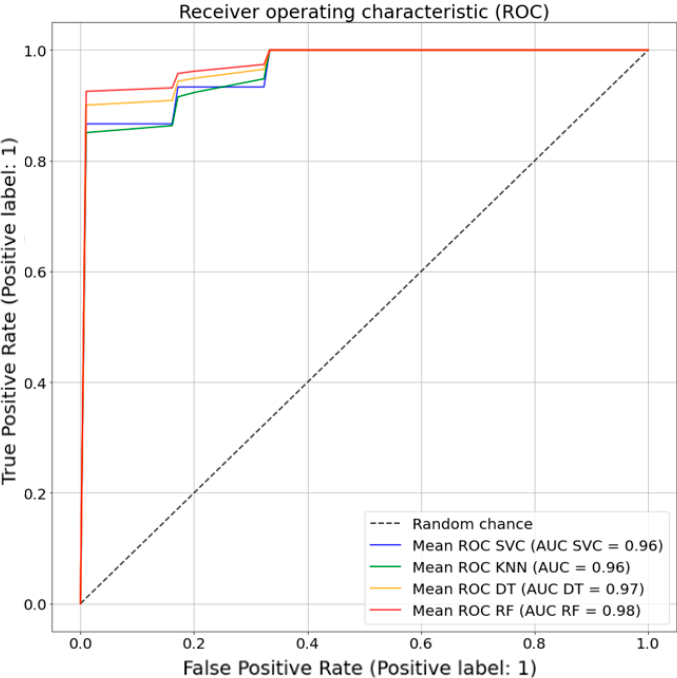
Figure 19. ROC curves and AUC value of each classifier.